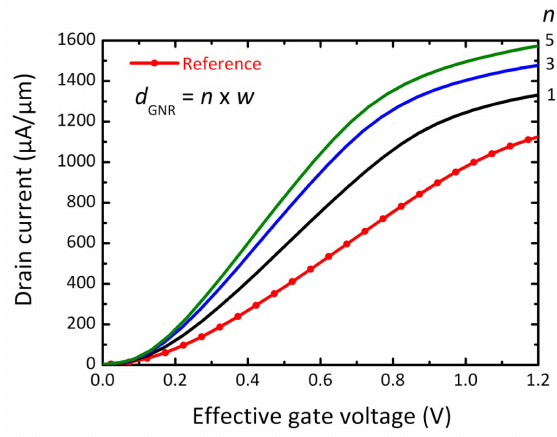
Figure 10. Transfer characteristics of multiple-channel GNR MOSFETs applying the correction factor approach (green, blue, and black lines). The transfer characteristics of the single-channel GNR MOSFET without interribbon gate (red line with symbols, designated as Reference), i.e. , the characteristics obtained using the original values of the dielectric constants of the gate dielectric ( ε r = 25) and the GNRs ( ε r = 1.8) are also